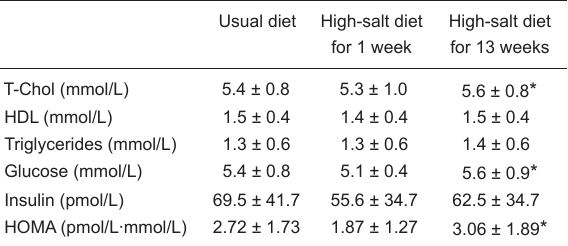
Table 2. Comparison of metabolic factors for subjects on differ- ent diets.